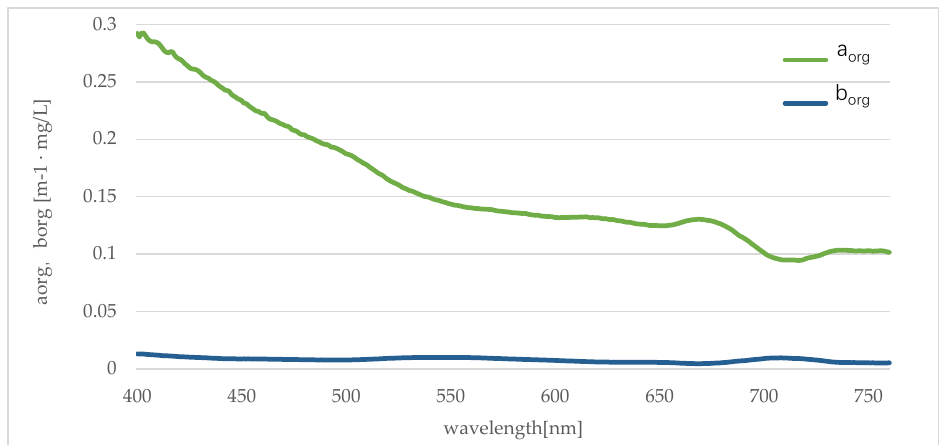
Figure 7. Absorption coefficient and backscatter coefficient of organic matter (represented by the permanganate index, COD Mn ).